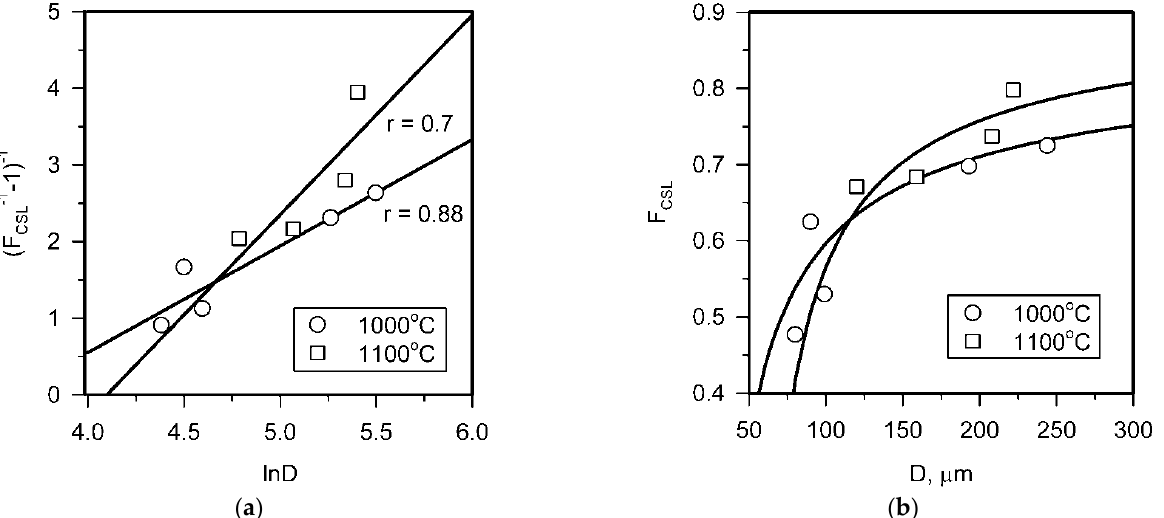
Figure 7. Change in the ∑ 3 n CSL boundary fraction (F CSL ) with increasing the grain size (D) shown as plots of (F CSL −1 − 1) − 1 vs. lnD ( a ) and F CSL vs. D ( b ) in a 316L stainless steel subjected to recrystallization annealing followed by grain growth.